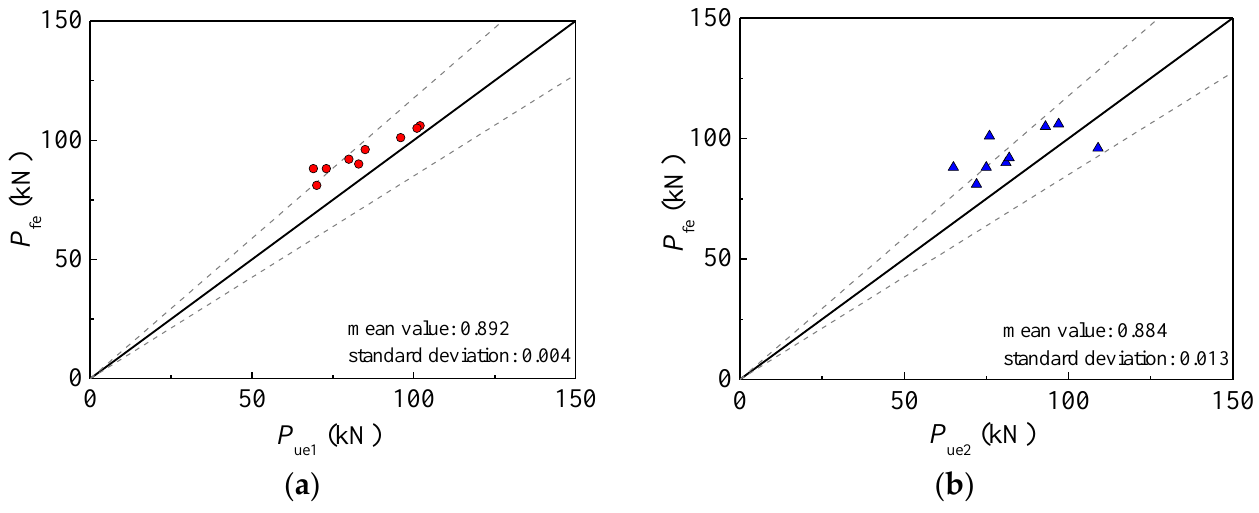
Figure 12. Comparison between P fe and P ue1 , P ue2 values of the specimens in Refs. [57–59]. ( a ) P fe / P ue1 ; ( b ) P fe / P ue2 .